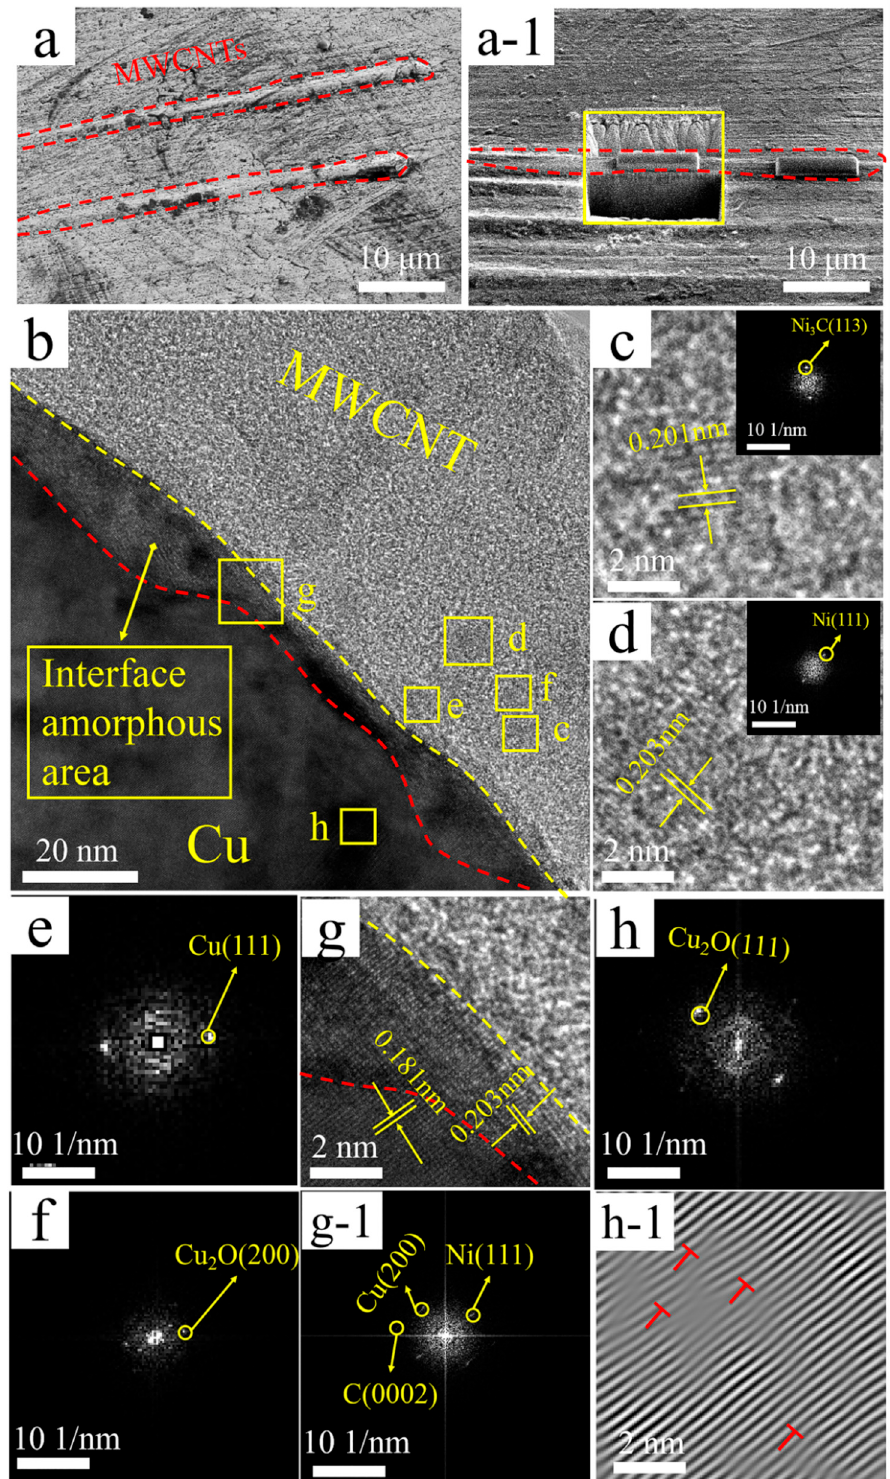
Figure 4. ( a ) SEM micrograph of Ni@MWCNTs/Cu composite, ( a-1 ) Sampling the manipulator at a, ( b ) TEM micrograph, ( c ) Enlarged view and FFT image of region c in b, ( d ) Enlarged view and FFT image of region d in b, ( e ) FFT image of region e in b, ( f ) FFT image of region f in b, ( g , g-1 ) Enlarged view and FFT image of region g in b, ( h , h-1 ) FFT and IFFT images of region h in b, dislocations marked with ‘T’ symbols.